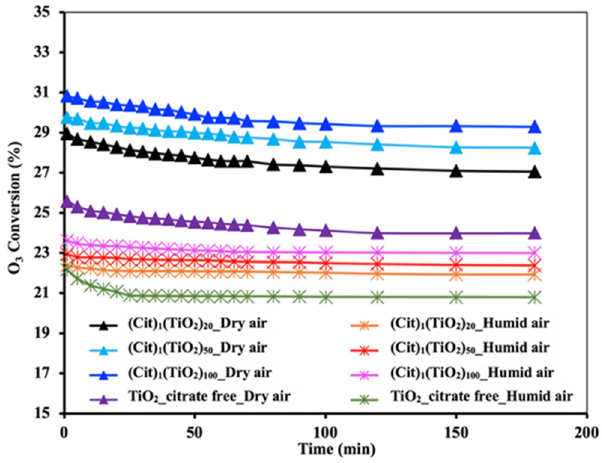
Figure 6. Ozone conversion as a function of time on stream in dry and humid conditions for the Pd free hybrid support (x = 20, 50, 100) and TiO 2 _citrate free reference. (Experimental conditions: catalyst = 10 mg, O 3 = 15 ppm, H 2 O = 3130 ppm (corresponding to RH = 10%), flow rate = 1000 mL min − 1 , T = 25 °C).